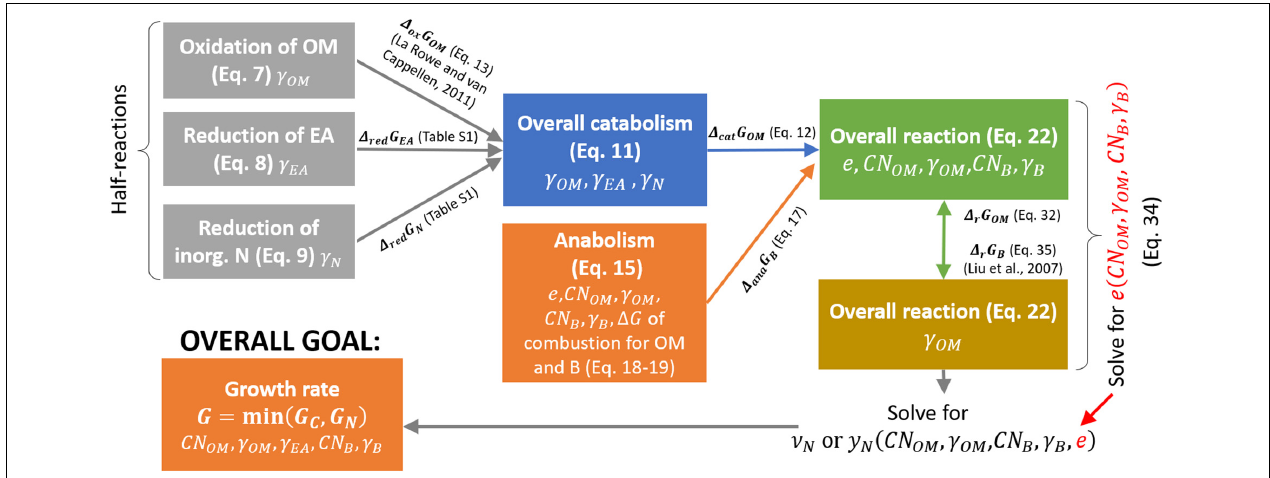
FIGURE 2 | Roadmap for the calculation of normalized microbial growth rate ( G ) as a function of OM and microbial C:N ratios ( CN OM and CN B , respectively), and degrees of reduction of OM, EA, and biomass ( γ OM , γ EA , and γ B , respectively). Each box refers to a half or overall reaction (with equation number in brackets) and includes the parameters affecting the reaction stoichiometry (listed at the bottom of each box). Arrows represent the changes in Gibbs energy associated to each half reaction, which is then used to calculate the changes in Gibbs energy of the overall reactions. Symbols are defined in Table 1